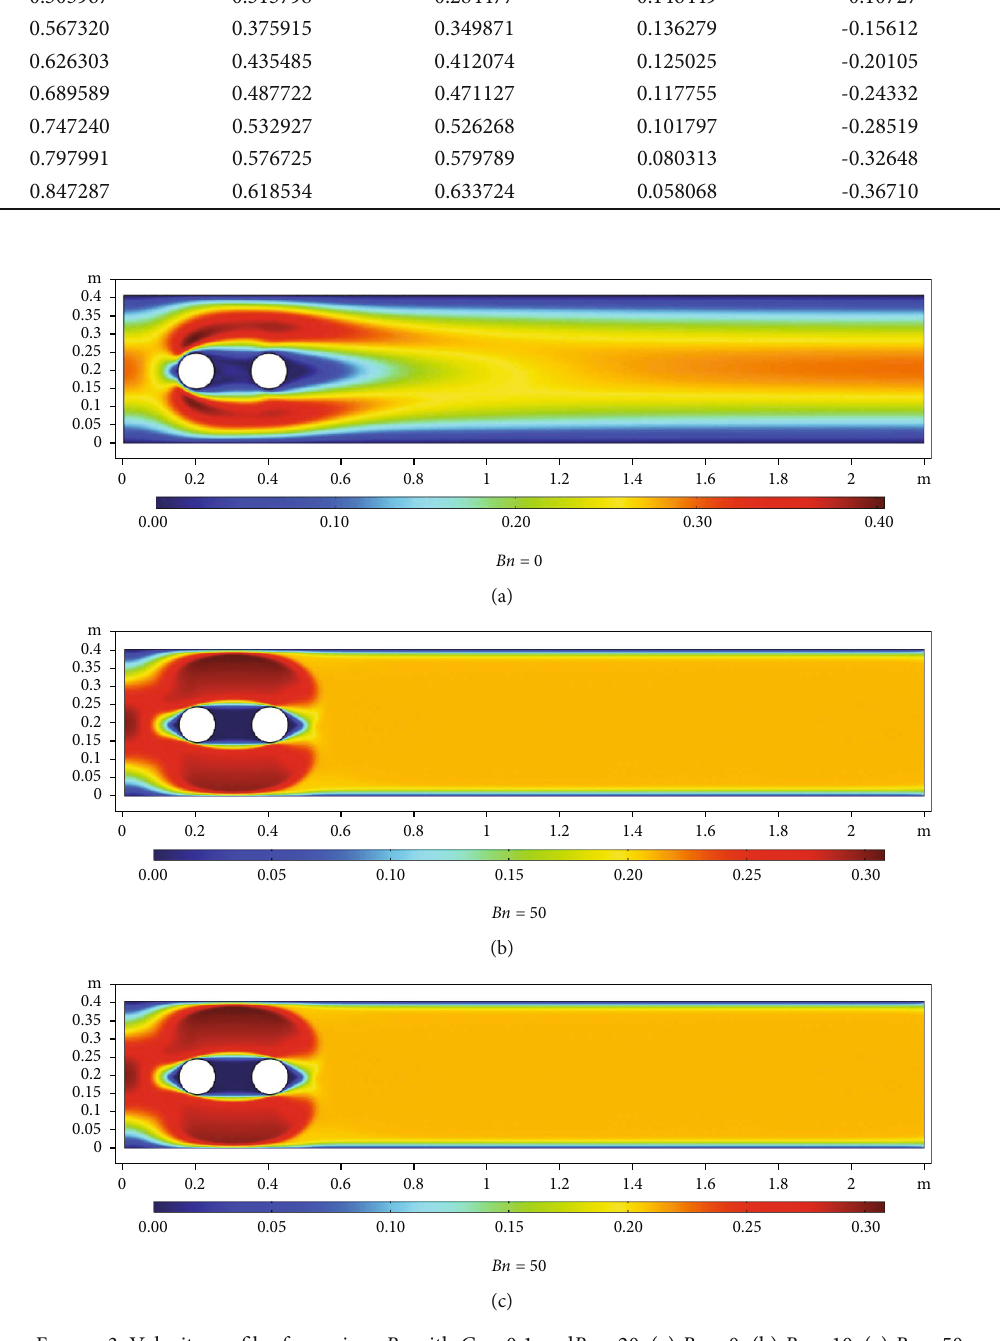
Figure 3: Velocity pro fi les for various Bn with G